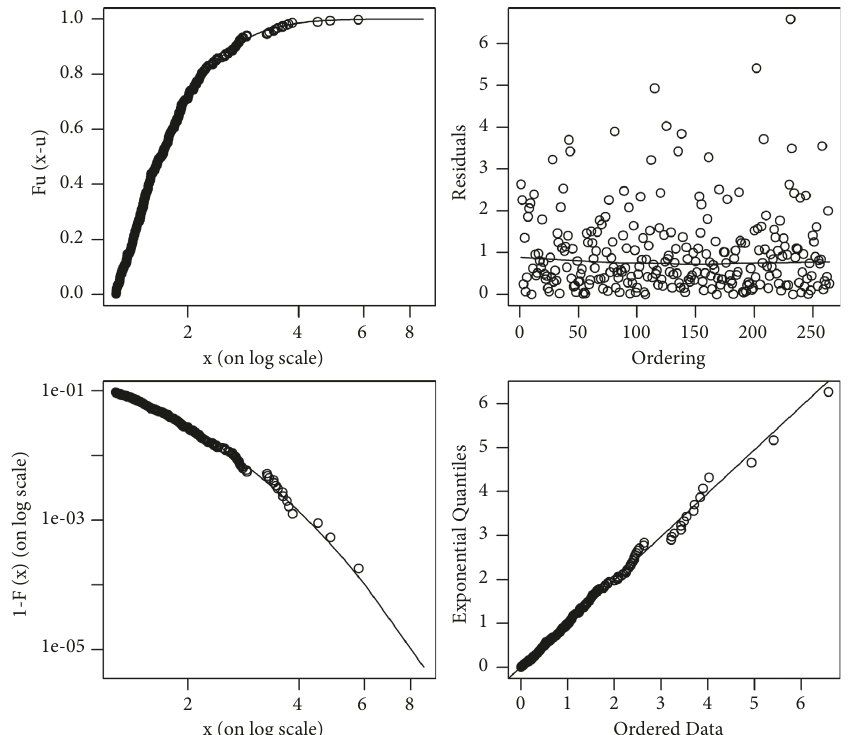
Figure 5: Soybean oil negative returns GPD fitted diagnostic plots.